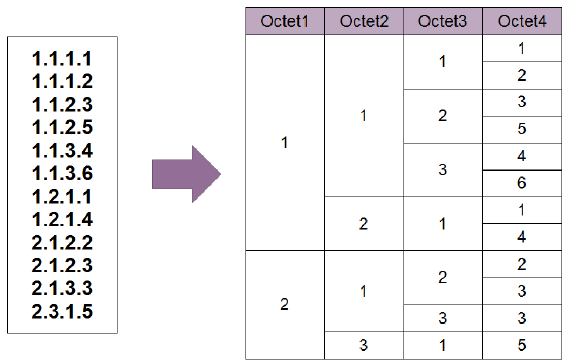
Figure 3: Classification of observed IP address.